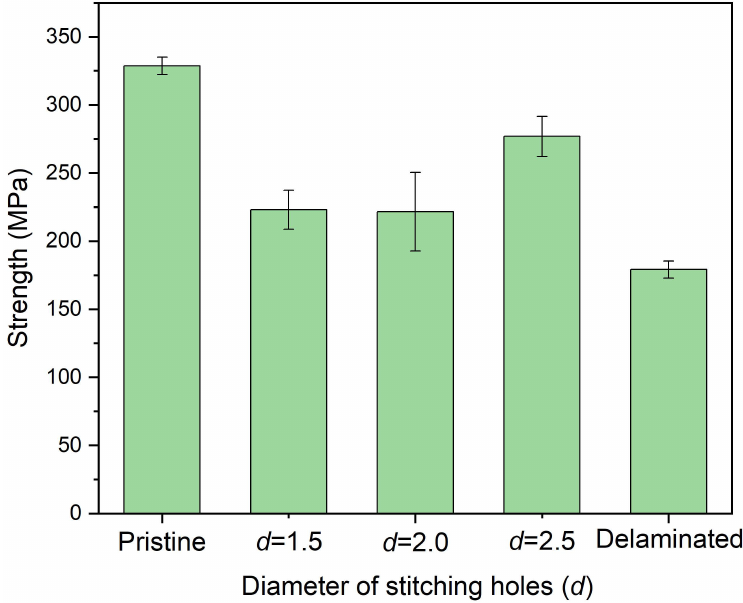
Figure 10. In-plane compressive strength of delaminated plates after stitching repair with different diameters of the stitching holes in which n = 6 and w = 0.8 were adopted.